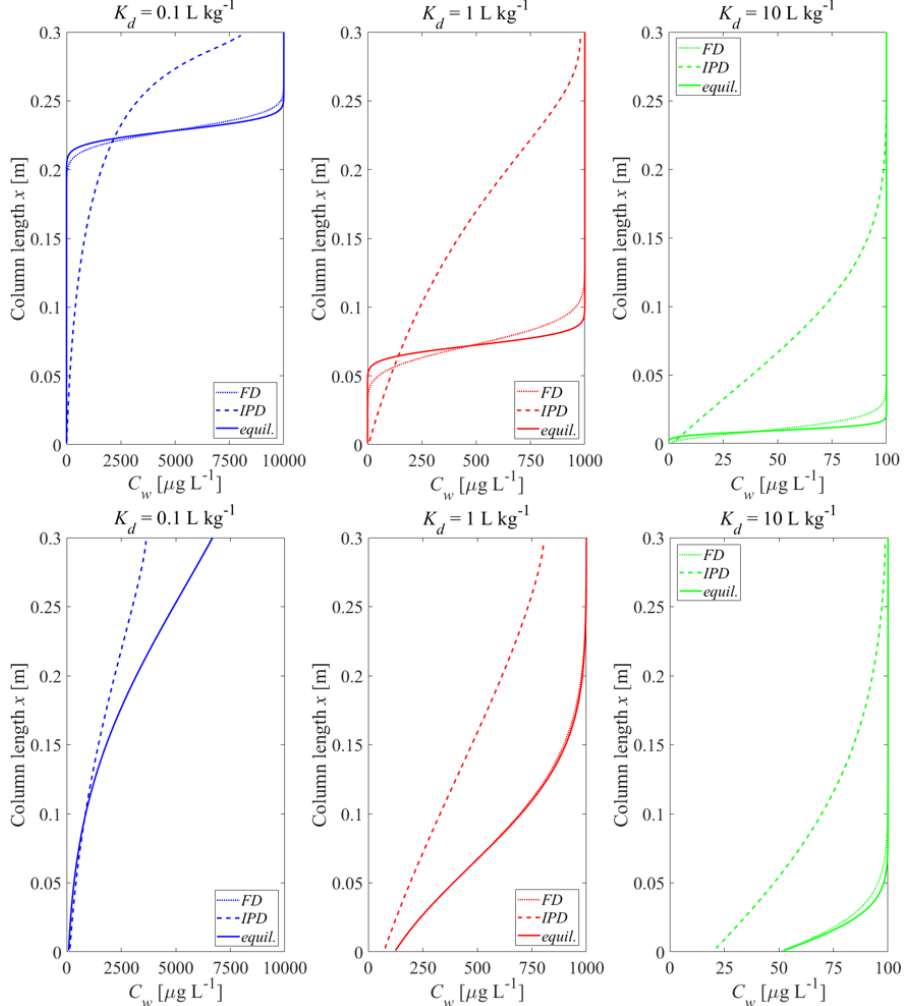
Figure 6. Initial aqueous concentration distributions in the column after the first flooding depending on the mass transfer limitation; dotted lines: film diffusion (FD), dashed lines: intraparticle diffusion (IPD); solid lines: fast kinetics (equilibrium, fine particles). Top panel : without dispersion; bottom panel : with dispersion; n = 0.45, v = 1.67 × 10 − 5 m s − 1 , α / x = 0 or 0.1, C s , ini = 1000 µ g kg − 1 , t c = 5 h, D aq = 1 × 10 − 9 m 2 s − 1 , ε = 0.05, d p , coarse = 2000 µ m, d p , fine = 63 µ